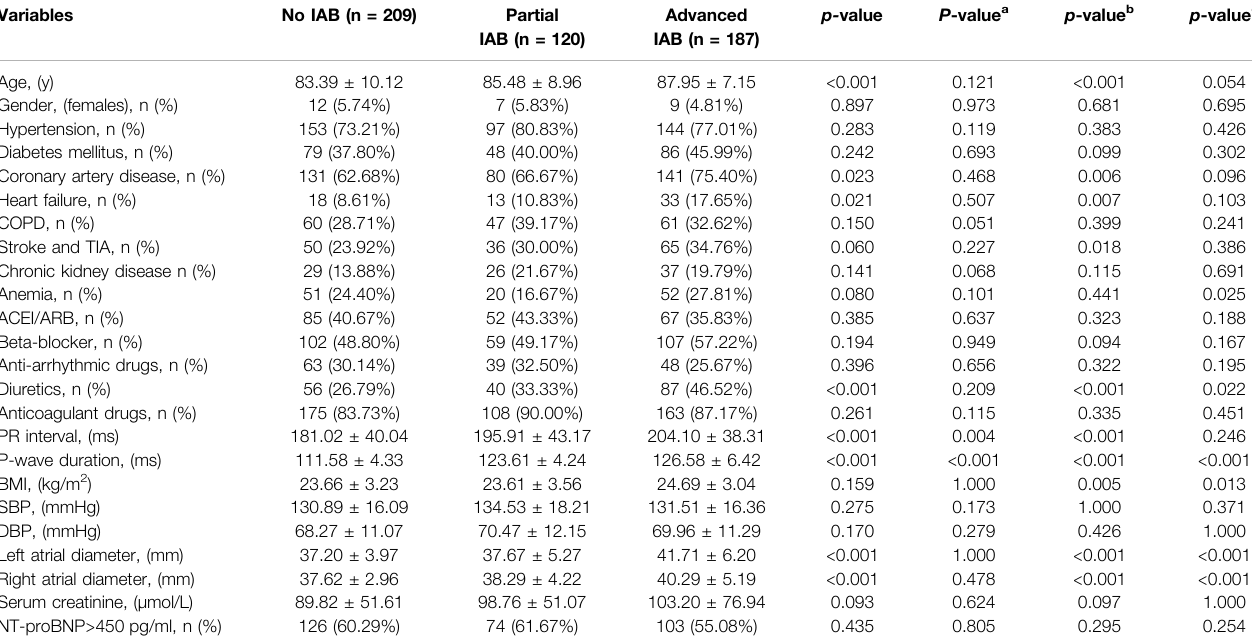
TABLE 1 | Baseline characteristics of the study participants with AF and hypertension according to the interatrial conduction.